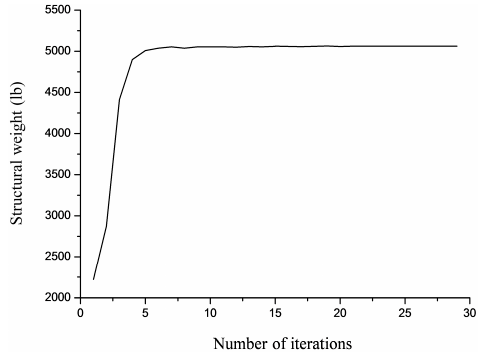
Figure 3. Convergence curve obtained for the 10-bar truss problem with N = 500.